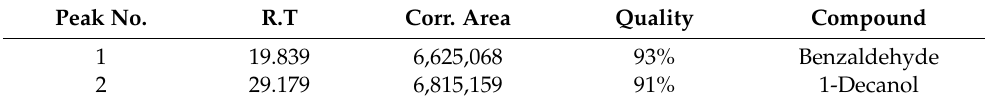
Table 1. Volatile organic compounds (VOCs) detected from sample of Tenax (Control). Peak No.